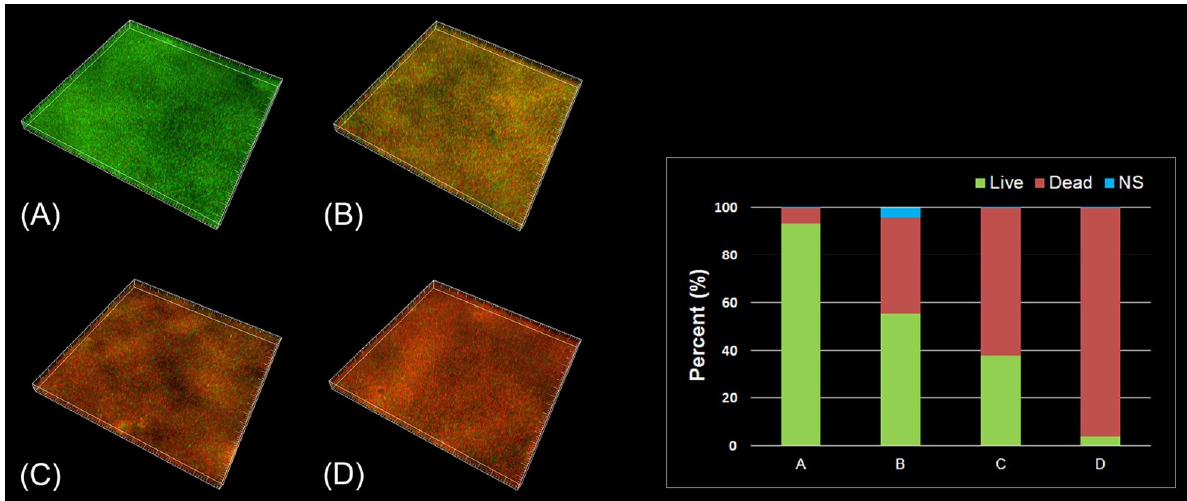
Figure 7. Confocal laser scanning microscope images of S. mutans biofilms and the percentage of live/dead cells. ( A ) The biofilms without treatment were performed by the same process as the control; ( B ) The biofilms were cultured for 12 h and then treated with 250 µg/mL hydroxyapatite (HAp)-binding antimicrobial peptide (HBAMP); ( C ) 500 µg/mL HBAMP for 10 min; ( D ) 0.12% chlorhexidine for 10 min. [167]. Reproduced from [167] © Creative Commons CC BY 4.0. Copyright 2016, Springer Nature.